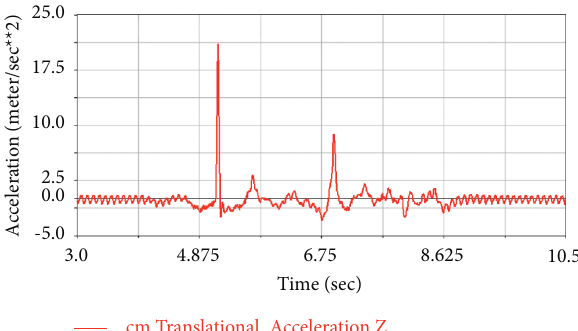
Figure 11: Vertical acceleration of the centroid in the process of crossing the trench.